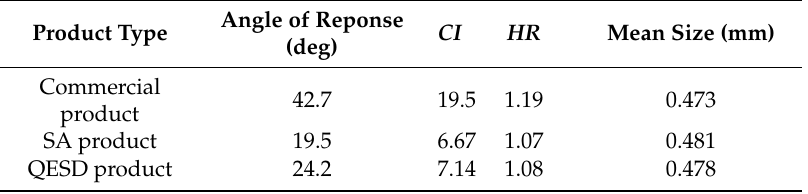
Table 1. Comparison of the commercial and spherical products.